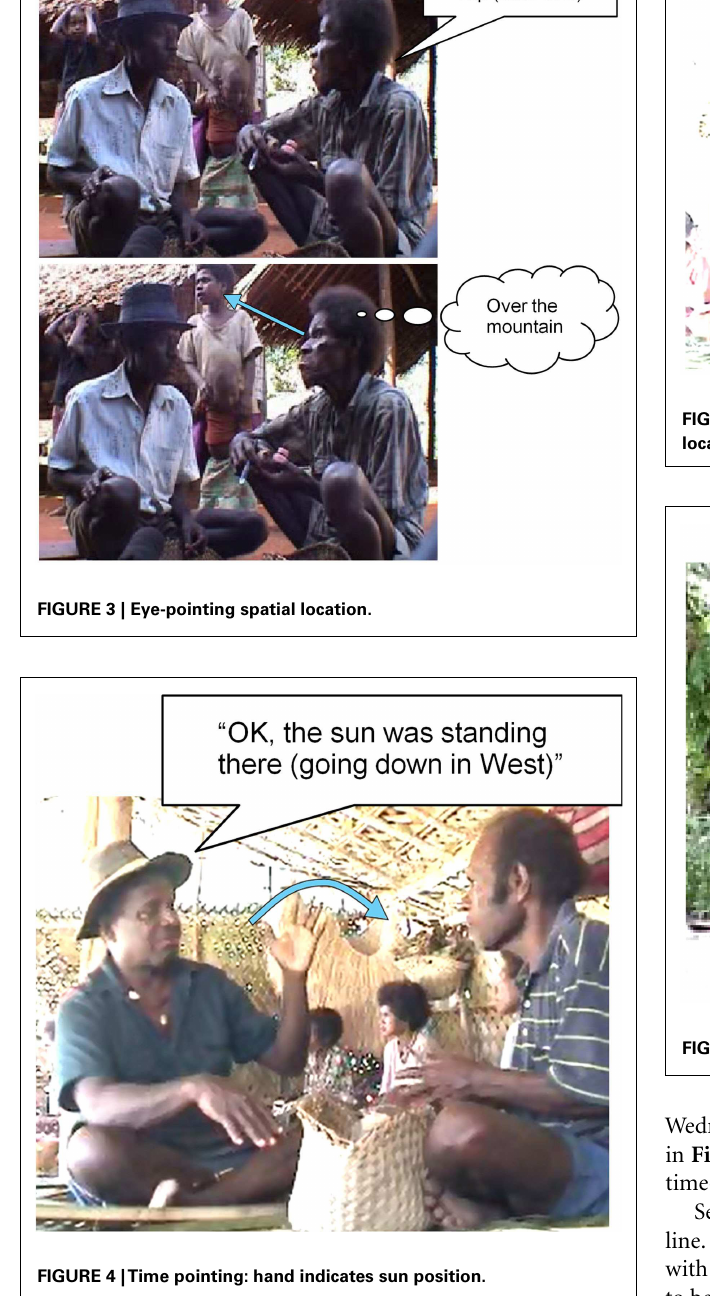
FIGURE 4 |Time pointing: hand indicates sun position.